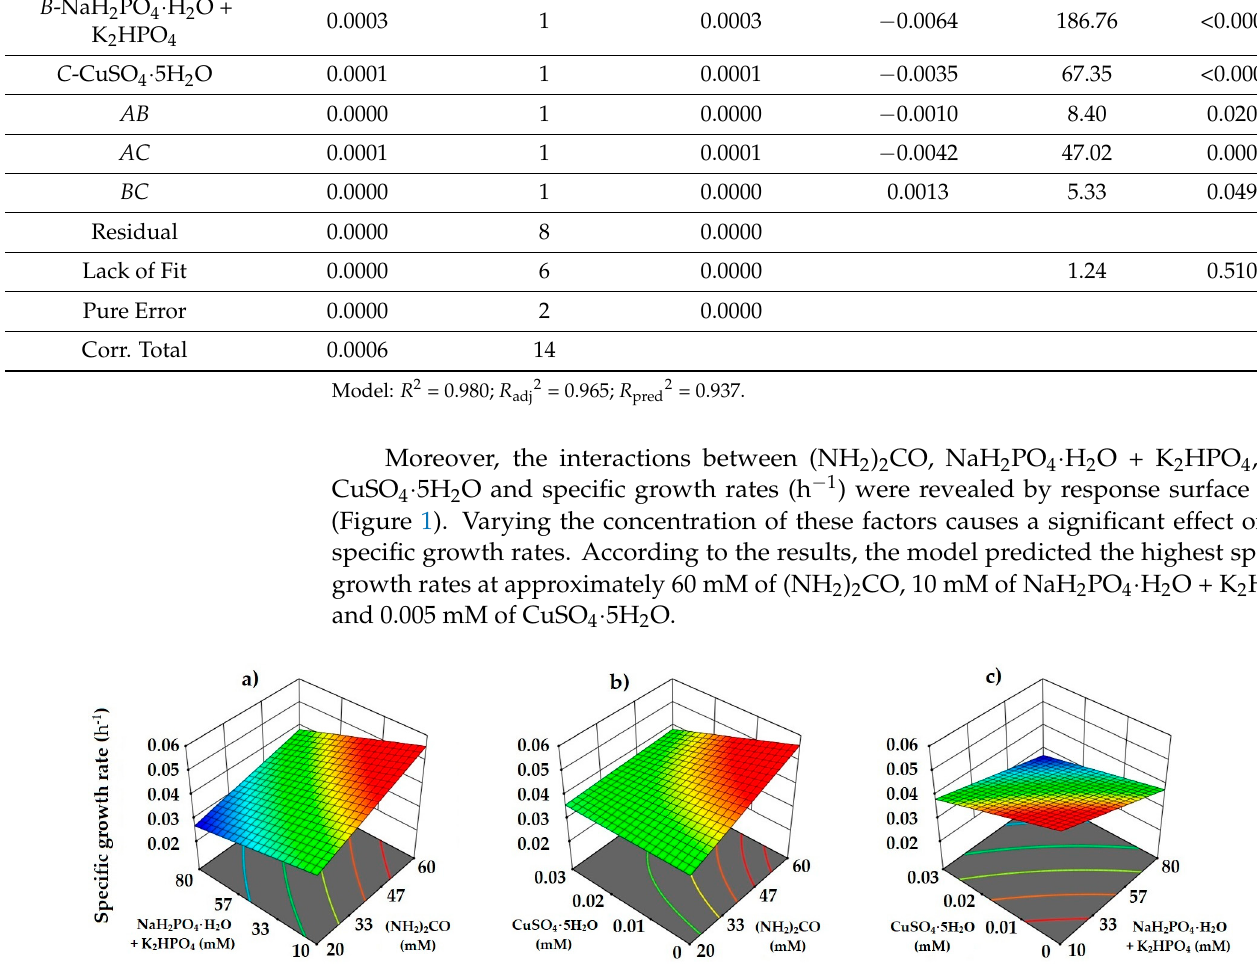
Table 4. Maximum and global volumetric productivities ( g.L − 1 .h − 1 ), specific growth rates ( h − 1 ),